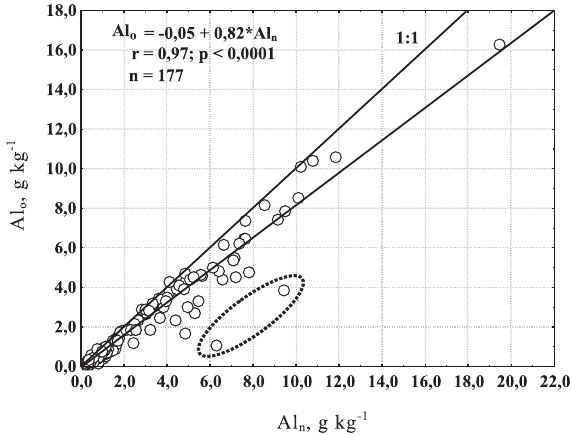
Figura 2. Relação entre o teor de Al extraído por NaOH (Al ) e o por oxalato (Al n